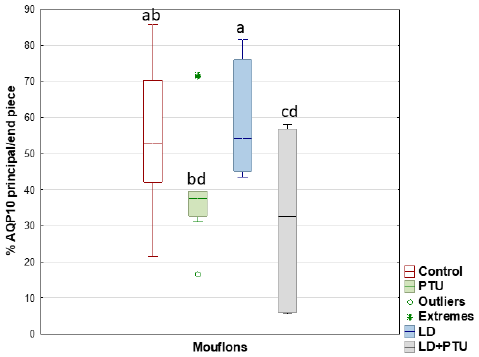
Figure 10. AQP10 expression by immunocytochemistry labelling (ICC) in principal and endpiece of tail of mouflon sperm (controls (red); administered propylthiouracil (PTU, green), exposed to long day photoperiod (LD, blue), exposed to long day photoperiod plus PTU (LD+PTU, gray)). The boxes spread form the 1st to the 3rd quartiles. Box plots show the median (horizontal line) and spread from the 1st to the 3rd quartiles; the whiskers extend from the smallest to the largest value. Outliers are shown as circles and extremes as asterisks. Different letters (a,b,c,d) between boxplots indicate significant differences (LD+PTU vs. Control, p = 0.05; LD+PTU vs. LD, p < 0.05).